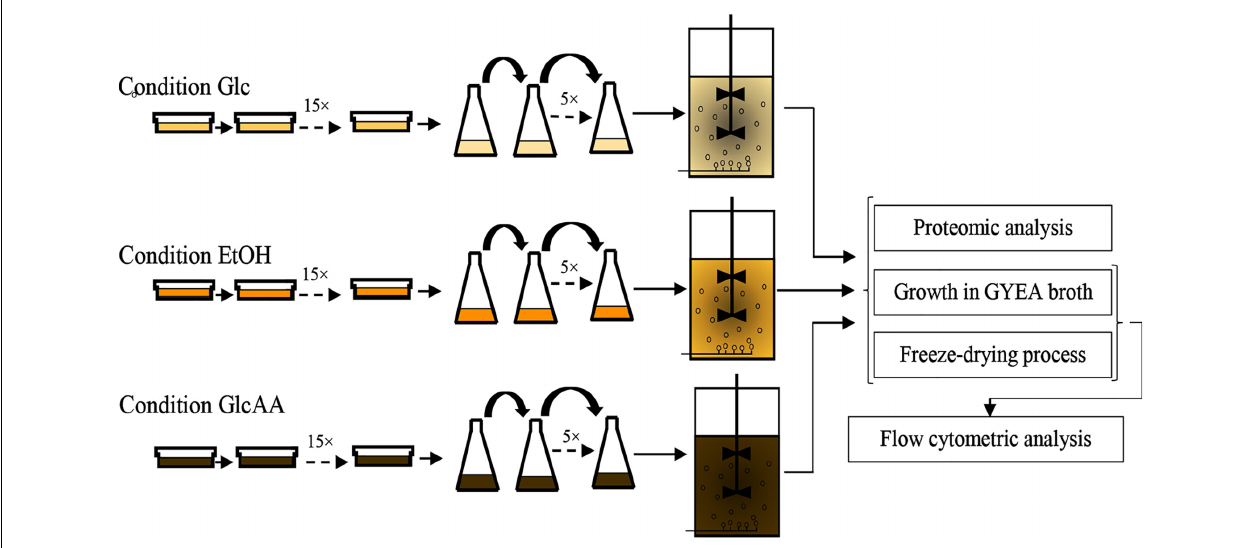
FIGURE 1 | Experimental procedure used for the sequential acclimation of Acetobacter senegalensis LMG 23690 T to different carbon sources.